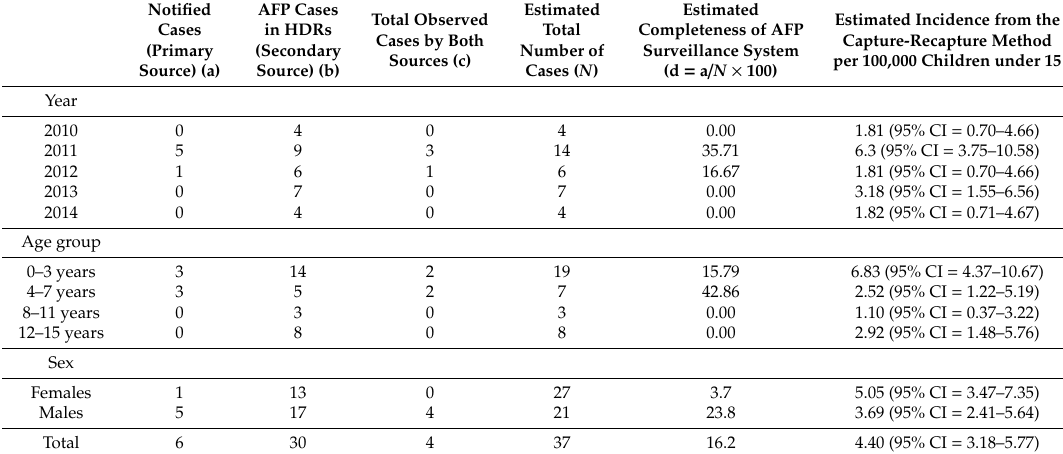
Table 1. Crude and stratified analysis by year of acute flaccid paralysis (AFP) ascertainment: cases ascertained (notified and in hospital discharge records HDRs) and estimated total